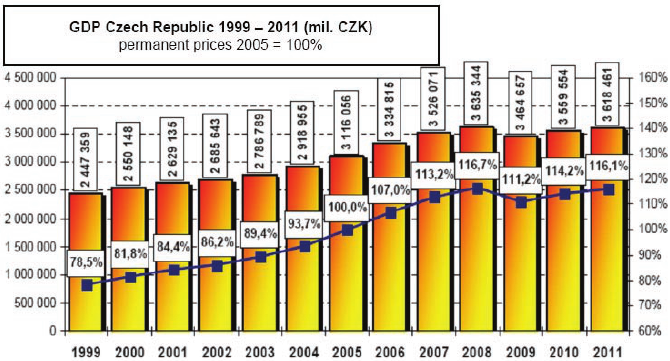
Fig. 1 – The Czech Republic GDP 1999 – 2011. Source: AutoSAP, 2012.